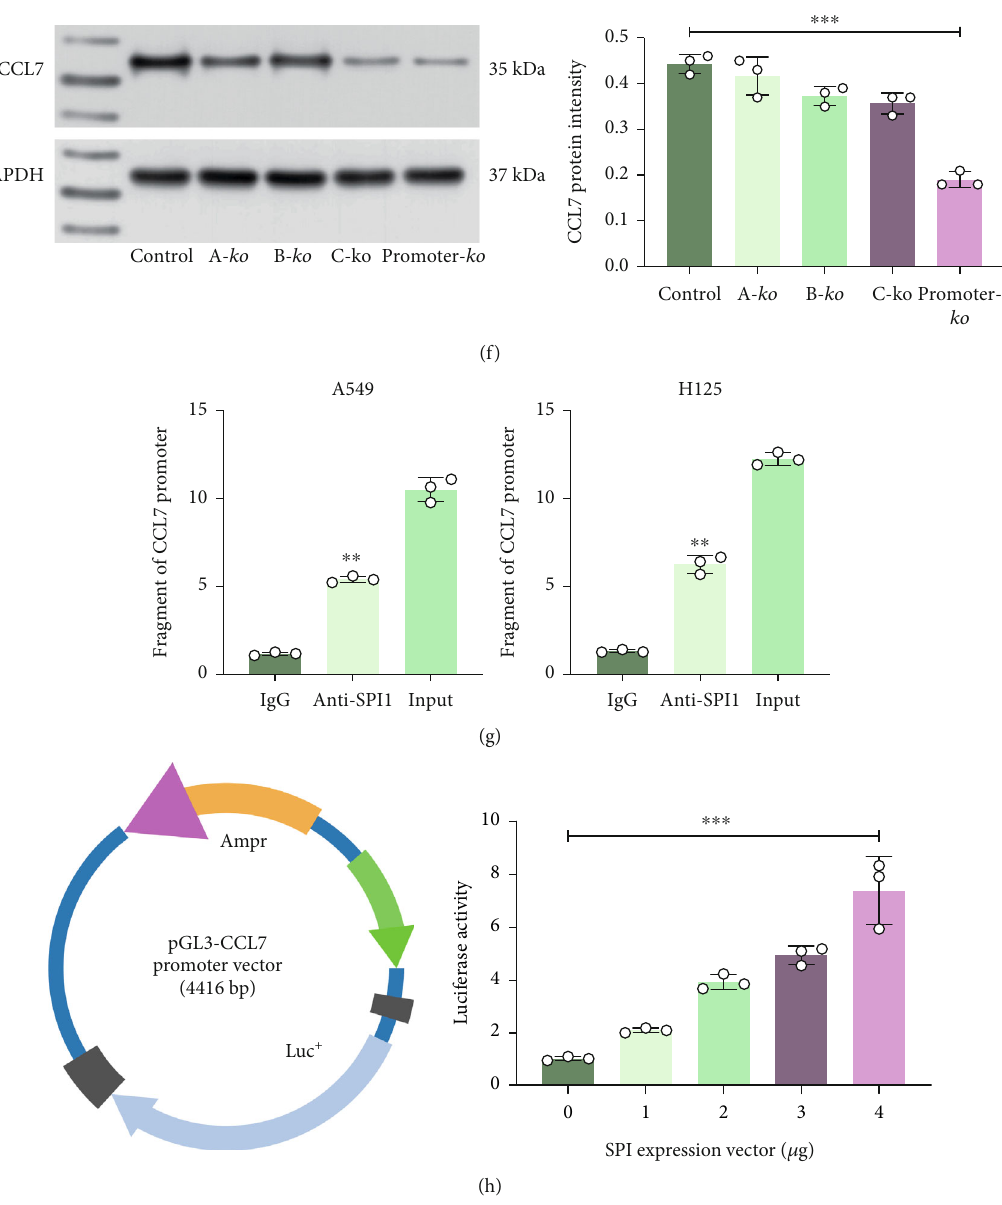
Figure 5: SPI1 promotes CCL7 transcription. (a) Transcription factors that can bind to CCL7 promoter with an over 0.5 correlation coe ffi cient in TCGA-LUAD analyzed using the R TFBS package; (b) binding sites between SPI1 and CCL7 promoter; (c) conservative binding sequence of SPI1; (d) a sketch map for the fragmentation of CCL7 promoter sites using the Crispr-Cas9 system; mRNA (e) and protein (f) levels of CCL7 in A549 cells after knockout of A, B, and C fragments alone or simultaneously; (g) CCL7 promoter fragments enriched by anti-SPI1 examined by the ChIP-qPCR assay; (h) construction of the pGL4-Luc luciferase vector containing the CCL7 promoter sequence for the examination of SPI1- CCL7 binding by luciferase assay. Repetition = 3 . Data are presented as the mean ± SD . ∗∗ p < 0 : 01